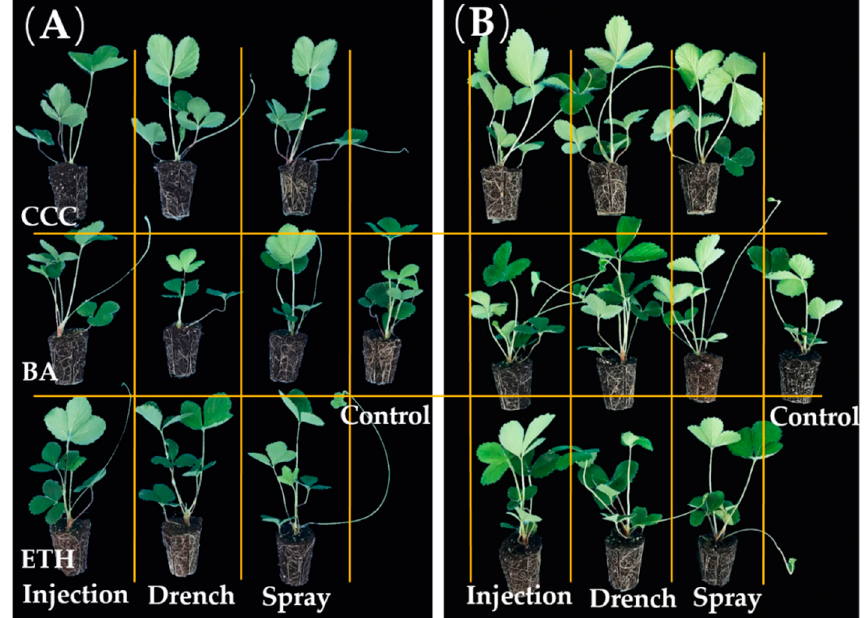
Figure 4. The effects of the chlormequat chloride (CCC), 6-benzylaminopurine (BA), and ethephon (ETH) at a concentration of 100 mg · L − 1 and the application method (injection, drench, and spray) on the morphology of strawberries ( A ) ‘Maehyang’ and ( B ) ‘Sulhyang’ runner plants grown for 30 days.